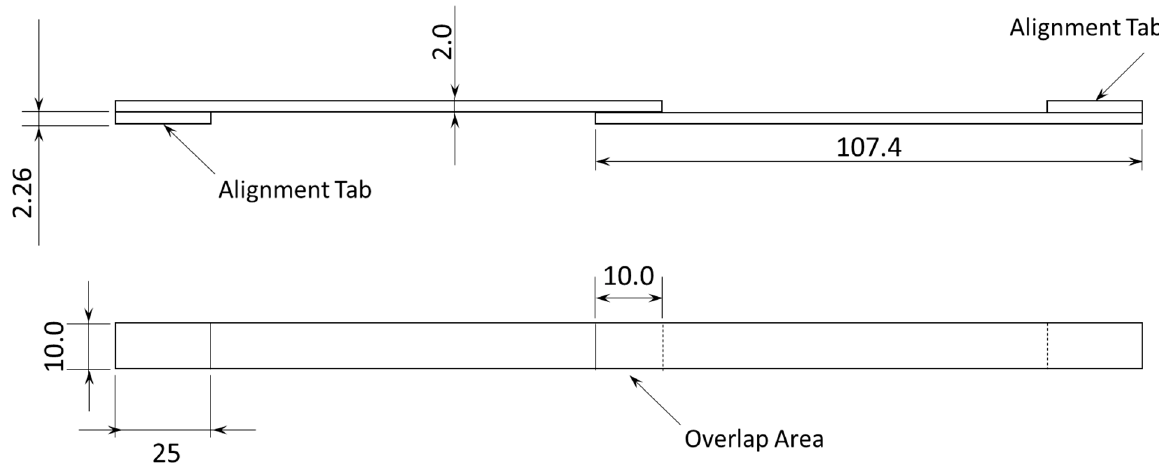
Figure 2. SLJ specimen’s geometry in mm.